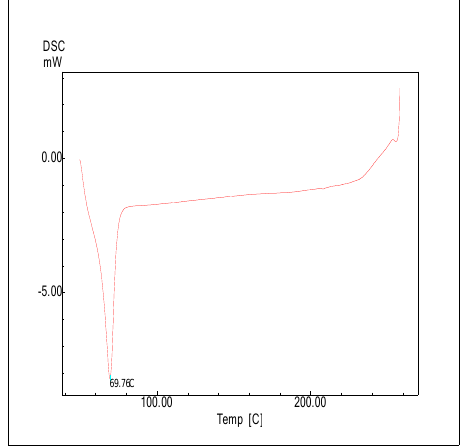
Figure 3. DSC thermogram of dariferacihy- drobromide loaded NLCs .